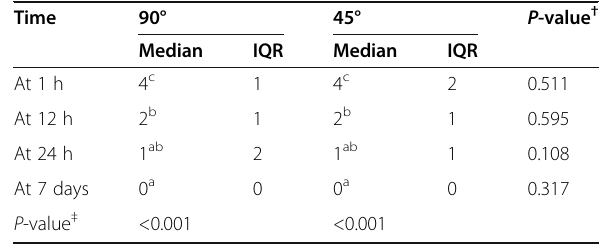
The failure rate of miniscrews is variable in the litera- ture. For example, Papageorgiou et al. [28] reported a failure rate of 13.5% while this rate was 14.5% in a study by Motoyoshi et al. [29] and 14.2% in a study by Watanabe et al. [22]. Table 2 Comparison of the median pain scores between the 45 and 90° miniscrew groups at different time points